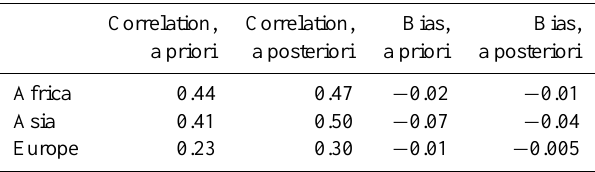
Table 3. Bias and correlation coefficient for comparison with inde- pendent satellite observations of AATSR for the considered regions. Correlation, Correlation, Bias, Bias, a priori a posteriori a priori a posteriori Africa 0.44 0.47 − 0.02 − 0.01 Asia 0.41 0.50 − 0.04 Europe 0.23 0.30 −